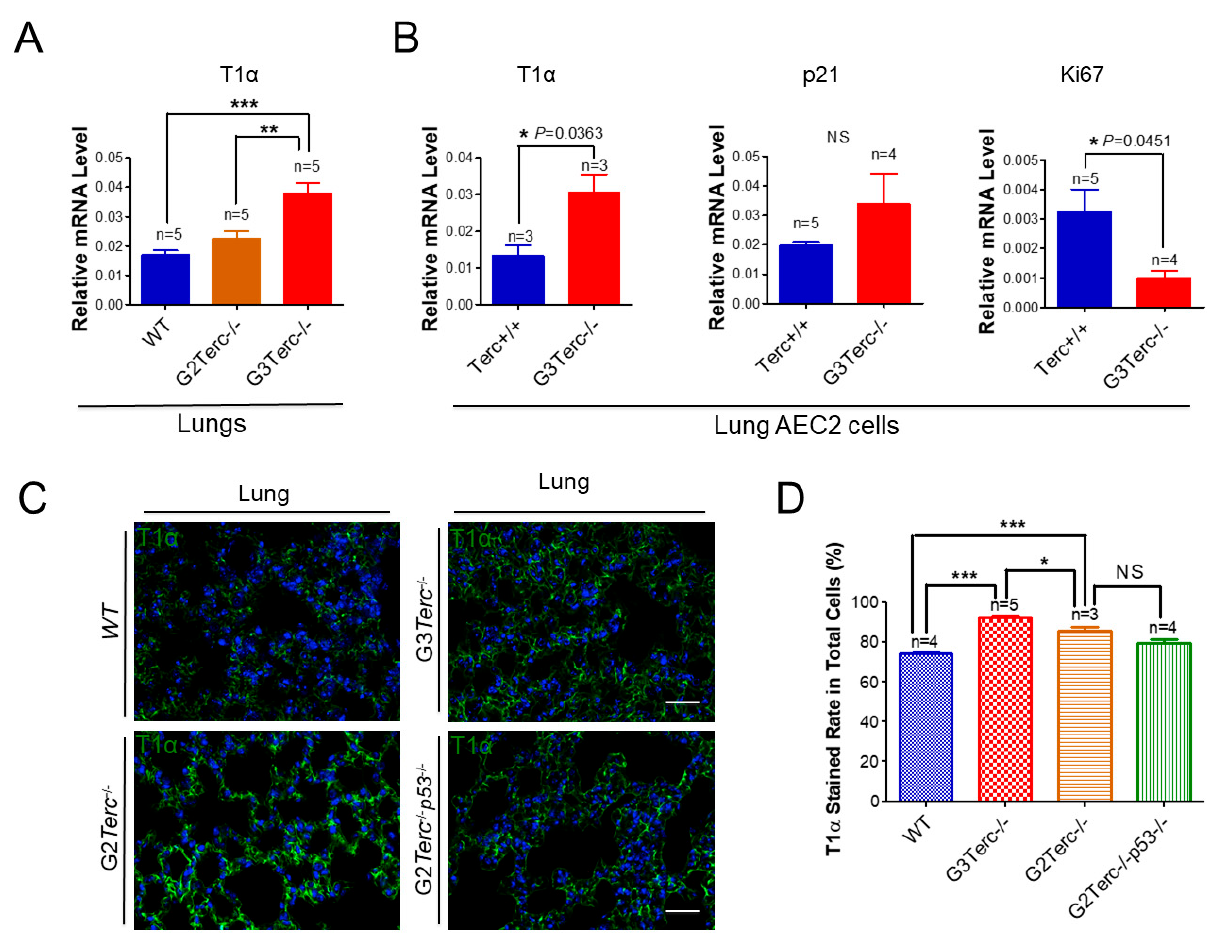
Figure 5. Significant elevation of AEC1 cell marker T1 α in both late-generation mouse lungs and isolated AEC2 cells, which was not rescued by p53 − / − . ( A ) qPCR analysis of T1 α mRNA levels from the indicated number of lungs. Data are expressed as mean ± SE values. ( B ) qPCR analysis of T1 α mRNA levels with AEC2 cell RNAs isolated from lungs by FACS sorting. Data are expressed as mean ± SE values based on the indicated animal numbers used to isolate lung AEC2 cells. ( C ) Representative T1 α immunofluorescence staining of WT, G3 Terc − / − , G2 Terc − / − , and G2 Terc − / − p53 − / − mouse lungs (magnification: 40×). Scale bar = 30 μ m. ( D ) Quantification of T1 α stained rate by cell counting (as in ( A )). Data are mean ± SE values based on the indicated number of lungs. Statistical significance is indicated by * p < 0.05, ** p < 0.01, *** p < 0.001.